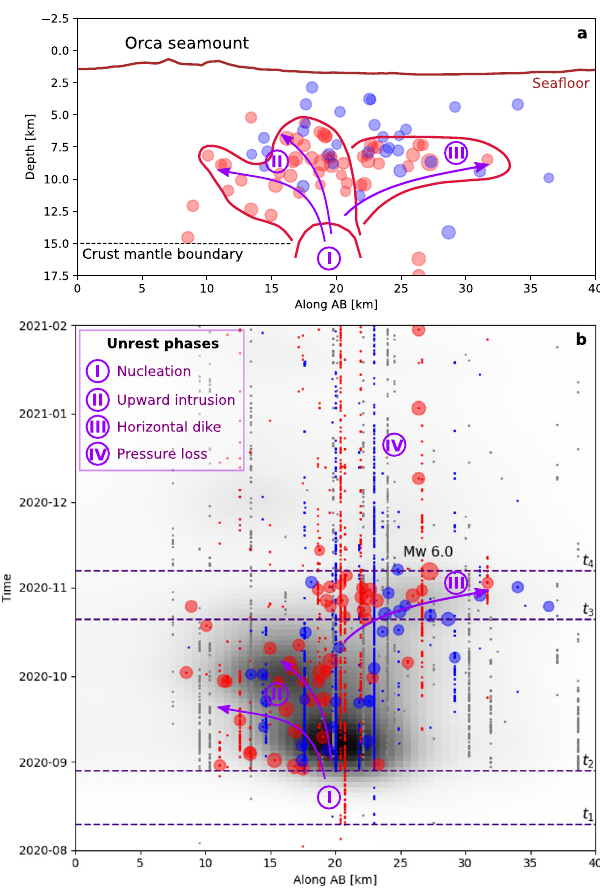
Fig. 3 Summary cartoon of the volcano-tectonic unrest. a Vertical cross- section along pro fi le AB (Fig. 2), with strike-slip events (red) marking the magma path (arrows) in different phases (numbers), and normal faulting events (blue) being triggered above the lateral dike intrusions. b Temporal evolution of seismicity along pro fi le AB, based on moment tensor solutions (circles), template matching (only events with threshold at 12 times the MAD and cross correlation values above 0.55 are shown) and single station analysis (grayscale kernel density plot). Horizontal indigo dashed lines mark the starting time of four phases of the unrest that are recognized: weak seismicity unrest marking the location of the depleting reservoir off the Orca seamount, below 15 km depth (phase I), upward and SW migration (phase II), further magma fl ux and formation of a horizontal dike towards NE (phase III) and seismicity drop, following the largest Mw 6.0 earthquake and dike pressure drop (phase